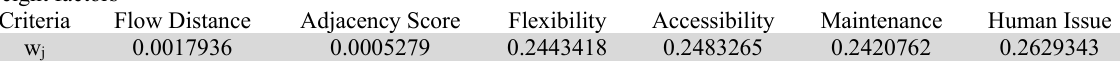
Weight factors Criteria Flow Distance Adjacency Score Flexibility Accessibility By considering these weighted factors, the weighted normalized decision matrix along with positive and negative ideal solutions A* and A’ (calculated by using Equations 9 and 10) are summarized in Table 25.